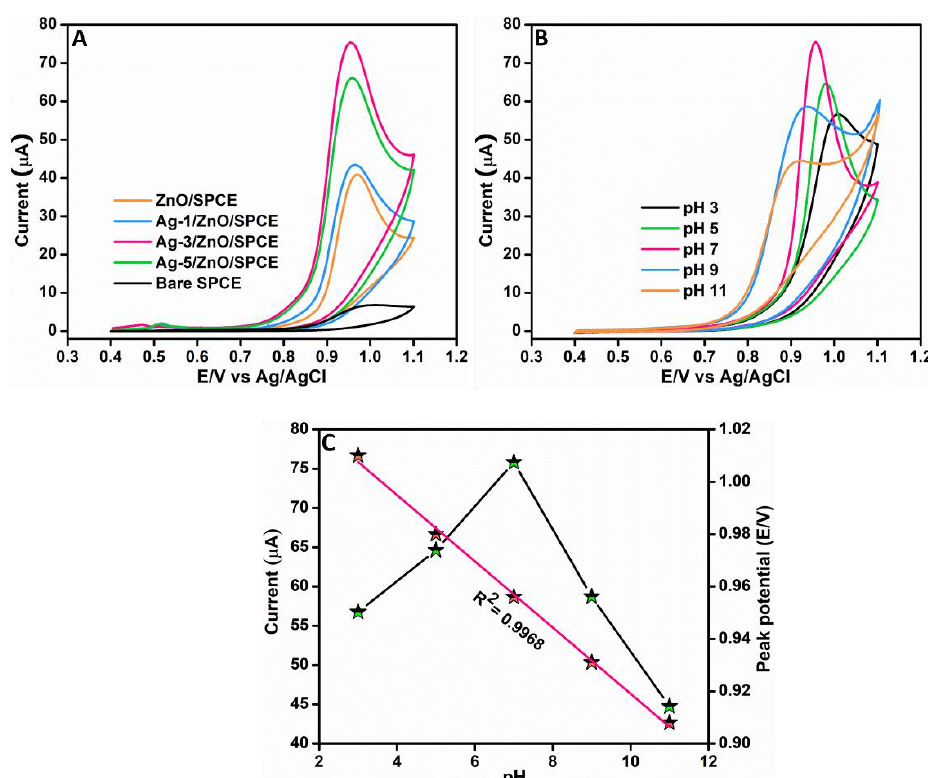
Figure 5. Voltammetric curves of different modified electrodes in 0.05 M PBS (pH 7.0) in presence of 100 μM RhB at 0.1 V/s ( A ). Voltammetric curves of Ag-3/ZnO/SPCE at different pH from pH 3 to pH 11 in presence of 100 μM RhB at 0.1 V/s ( B ). The pH against peak current and potential ( C ).